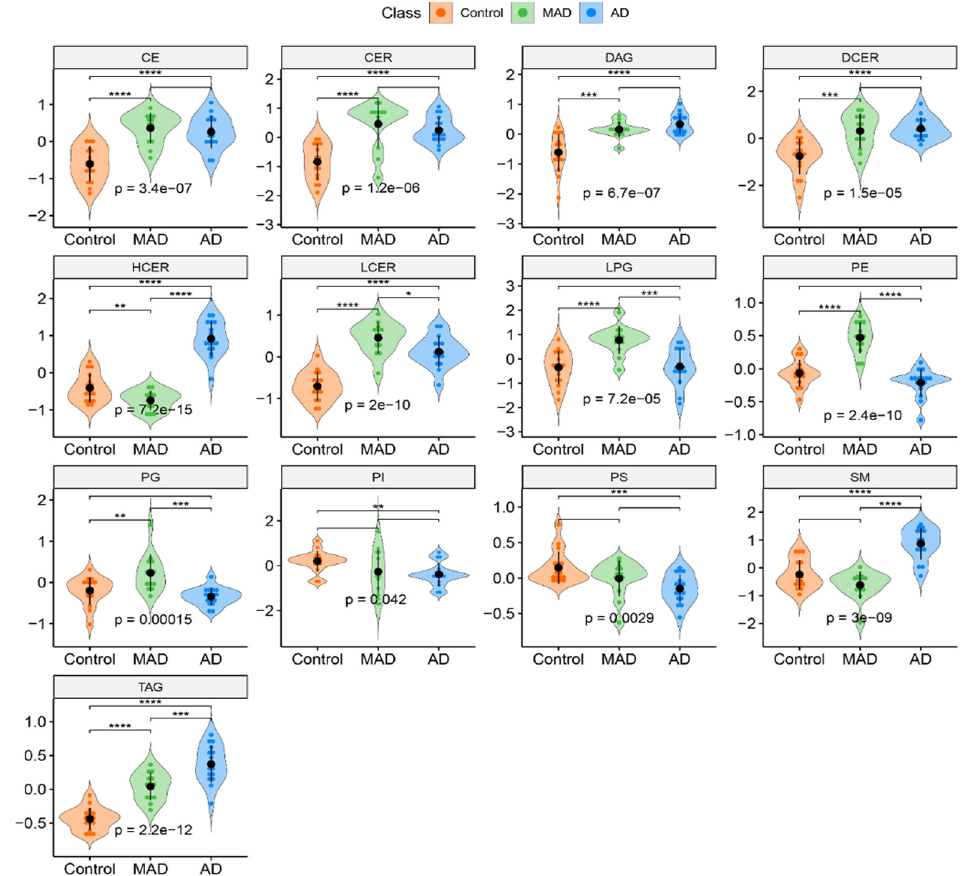
Figure 2. Violin plots comparing the median concentration of different total species of complex lipids in the brain among AD (n = 16), mild AD (n = 15), and control (n = 16) groups. Data was analyzed by t -test, where: ns, p > 5 × 10 − 2 ; * p < = 5 × 10 − 2 ; ** p < = 1 × 10 − 2 ; *** p < = 1 × 10 − 3 ; **** p < = 1 × 10 − 4 . Abbreviations: CE, cholesteryl esters; CER, ceramides; DAG, diacylglycerols; DCER, dihydroceramides; HCER, hexosylceramides; LCER, lactosylceramides; LPG, lysyl-phosphatidylglycerol; MAD, Mild AD (Mild Alzheimer’s disease); PE, phosphatidylethanolamine; PG, phosphatidylglycerol; PI, phosphatidylinositol; PS, phosphatidylserine; SM, sphingomyelins; TAG, triacylglycerols.